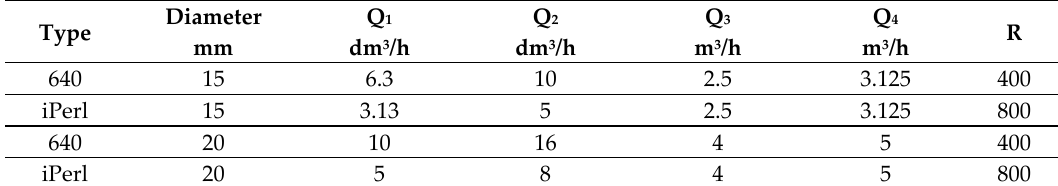
Table 1. parameters of installed and planned to be installed water